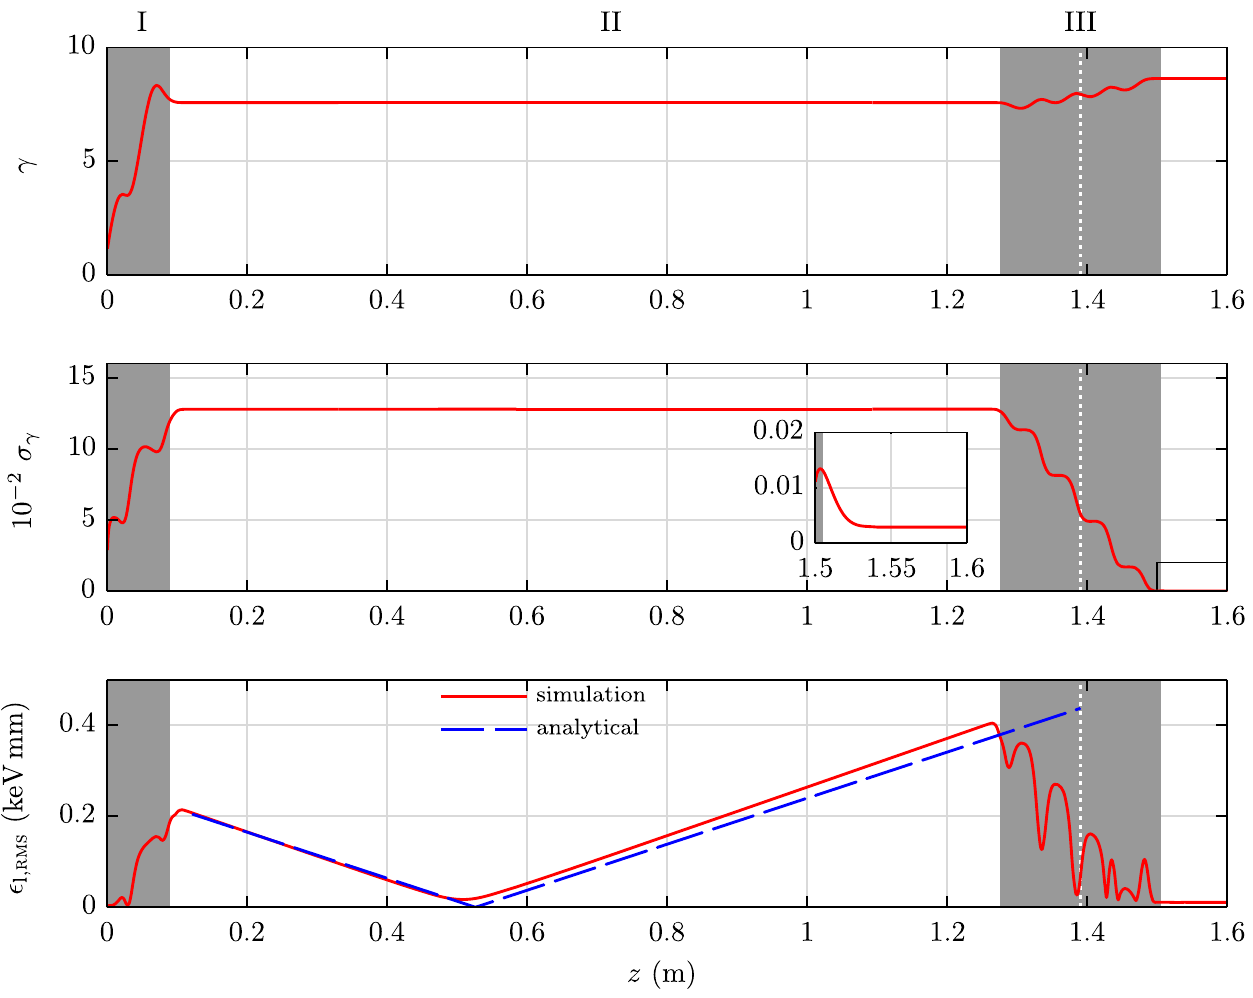
of a bunch for the energy spread ; RMS